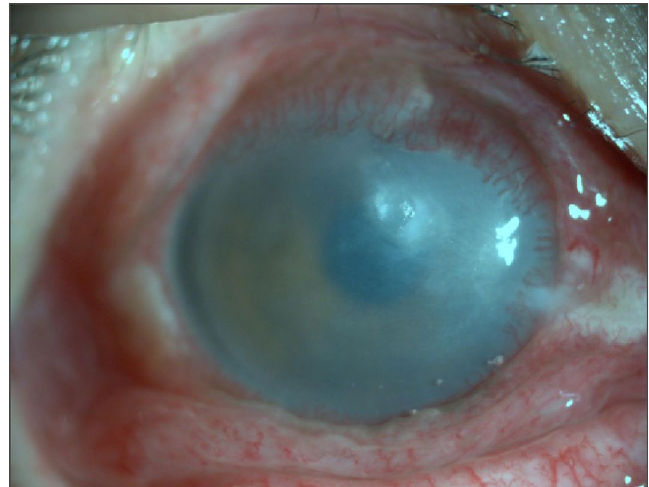
Figure 1. A representative ocular surface photography of severe